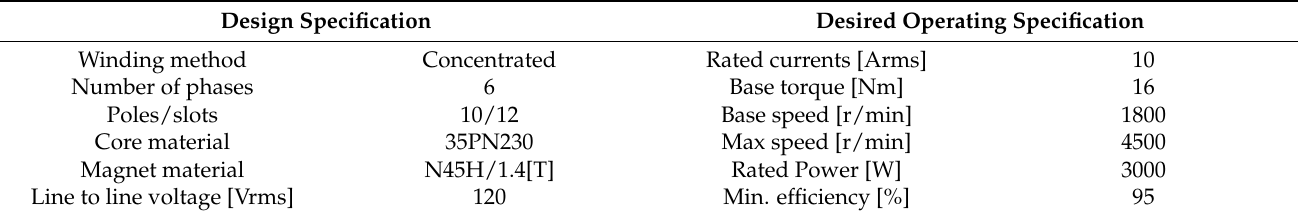
Table 1. Design specifications of a six-phase PMa-SynRM.